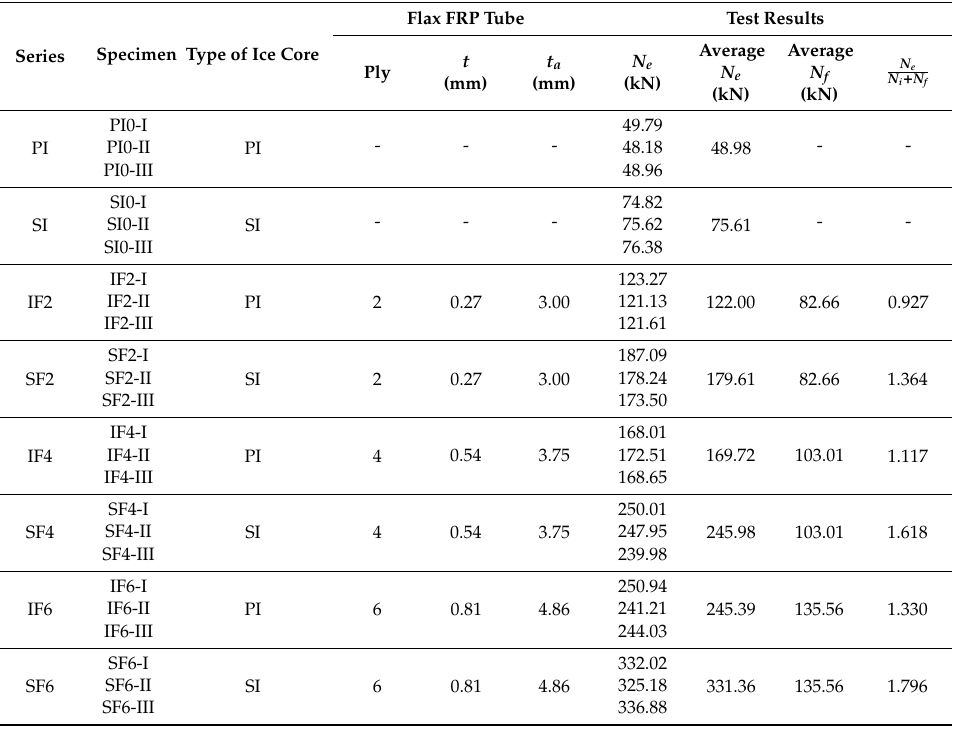
Table 1. Details of specimens and main test